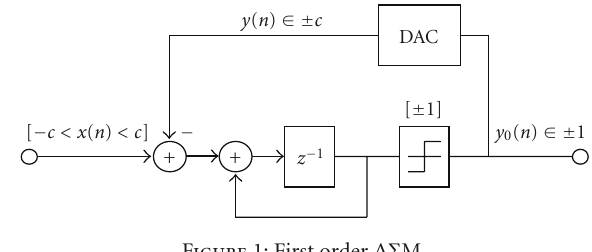
Figure 1: First order ΔΣ